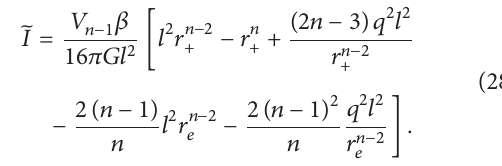
Using these relations, the regulated action